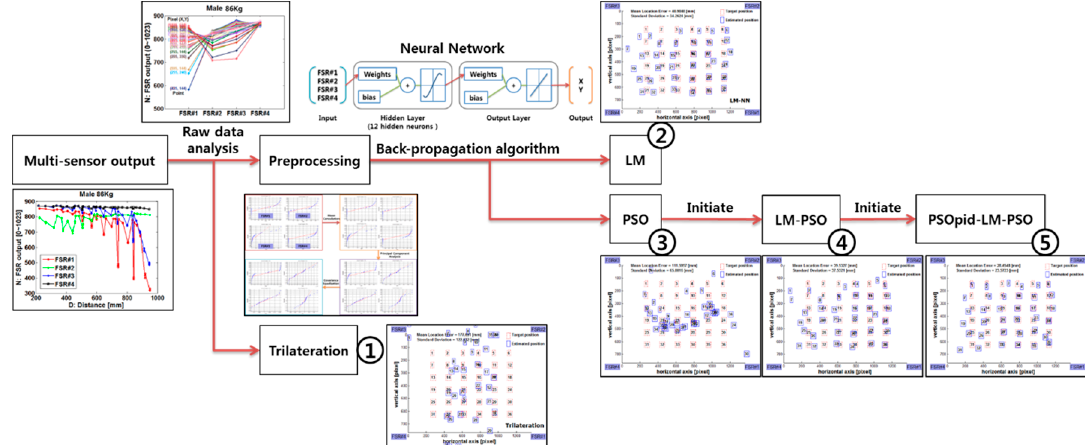
Figure 7. Performance analysis.